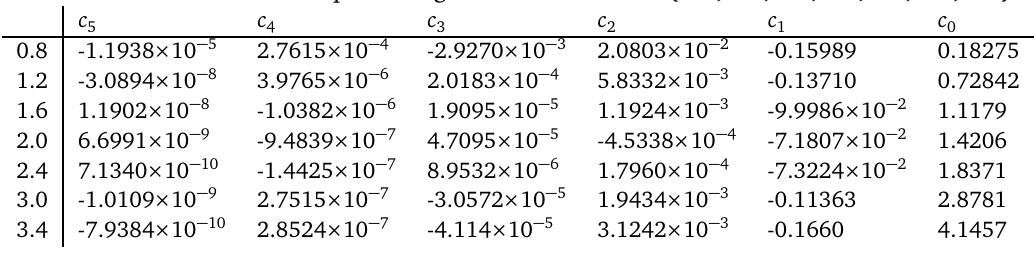
Table 1: Coefficients in fifth degree polynomial representations of the computed chemical potential between solid and liquid along the isotherms T = { 0.8,1.2,1.6,2.0,2.4,3.0,3.4 }